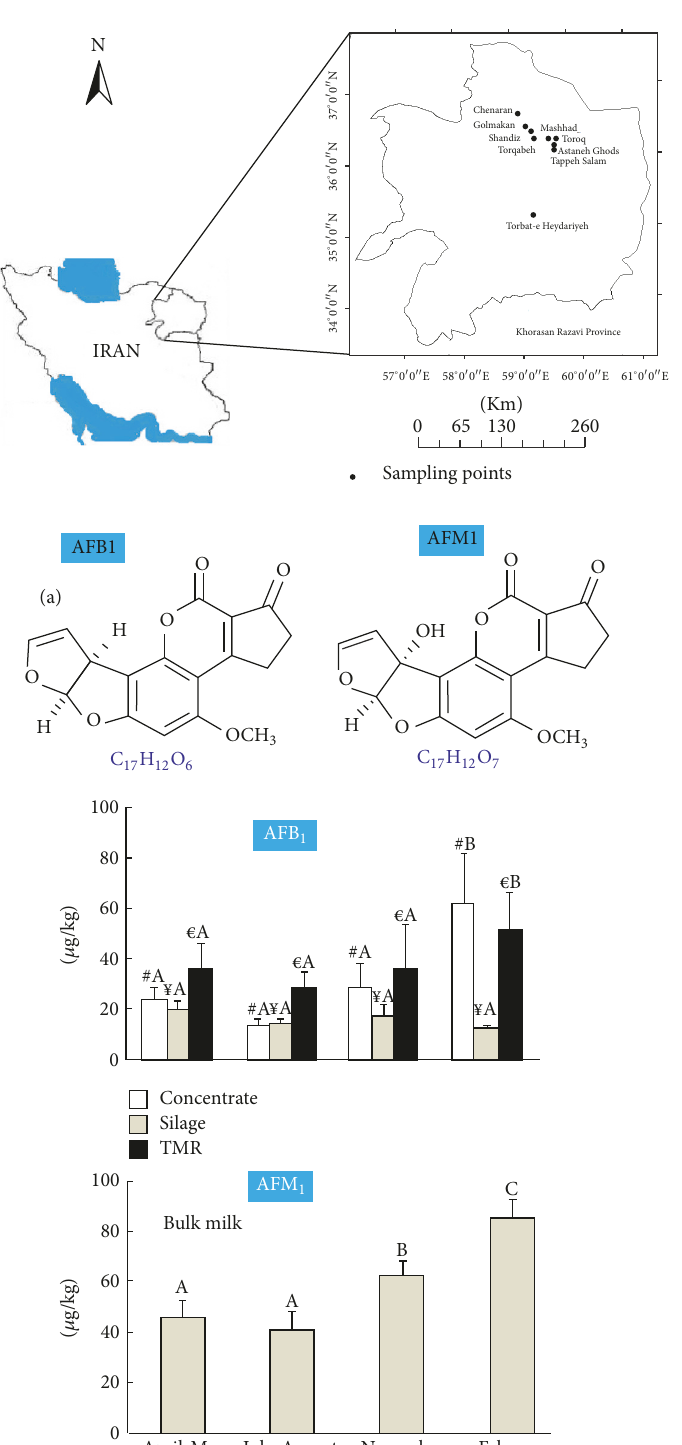
Figure 1: Upper panel, map of the study area showing many intensively large scaled industrial cattle farming in part of semiarid northeastern Iran, where feed and milk samples were seasonally obtained. Lower panel (a), chemical structure of aflatoxins (AFs) B 1 (C 17 H 12 O 6 ) and M 1 (C 17 H 12 O 7 ) routinely found in animal feed and milk. AFM 1 is derivative of hydroxy AFB 1 and predominant secondary metabolite of AFB 1 . One oxygen atom more in AFM 1 leads to a polar lipophobic toxin. Middle, aflatoxin B 1 levels in different types of cattle feed ( 𝑛 = 72 feedstuffs), and lower, aflatoxin M 1 levels in bulk milk ( 𝑛 = 200 ) during four seasons (in 𝑦 -axes, kg is equal to liter). Different letters with their symbols (i.e., #, ¥, and € for concentrate, silage, and TMR/totally mixed ration, resp.) represent significant difference between their respective treatments ( 𝑃 < 0.05 versus